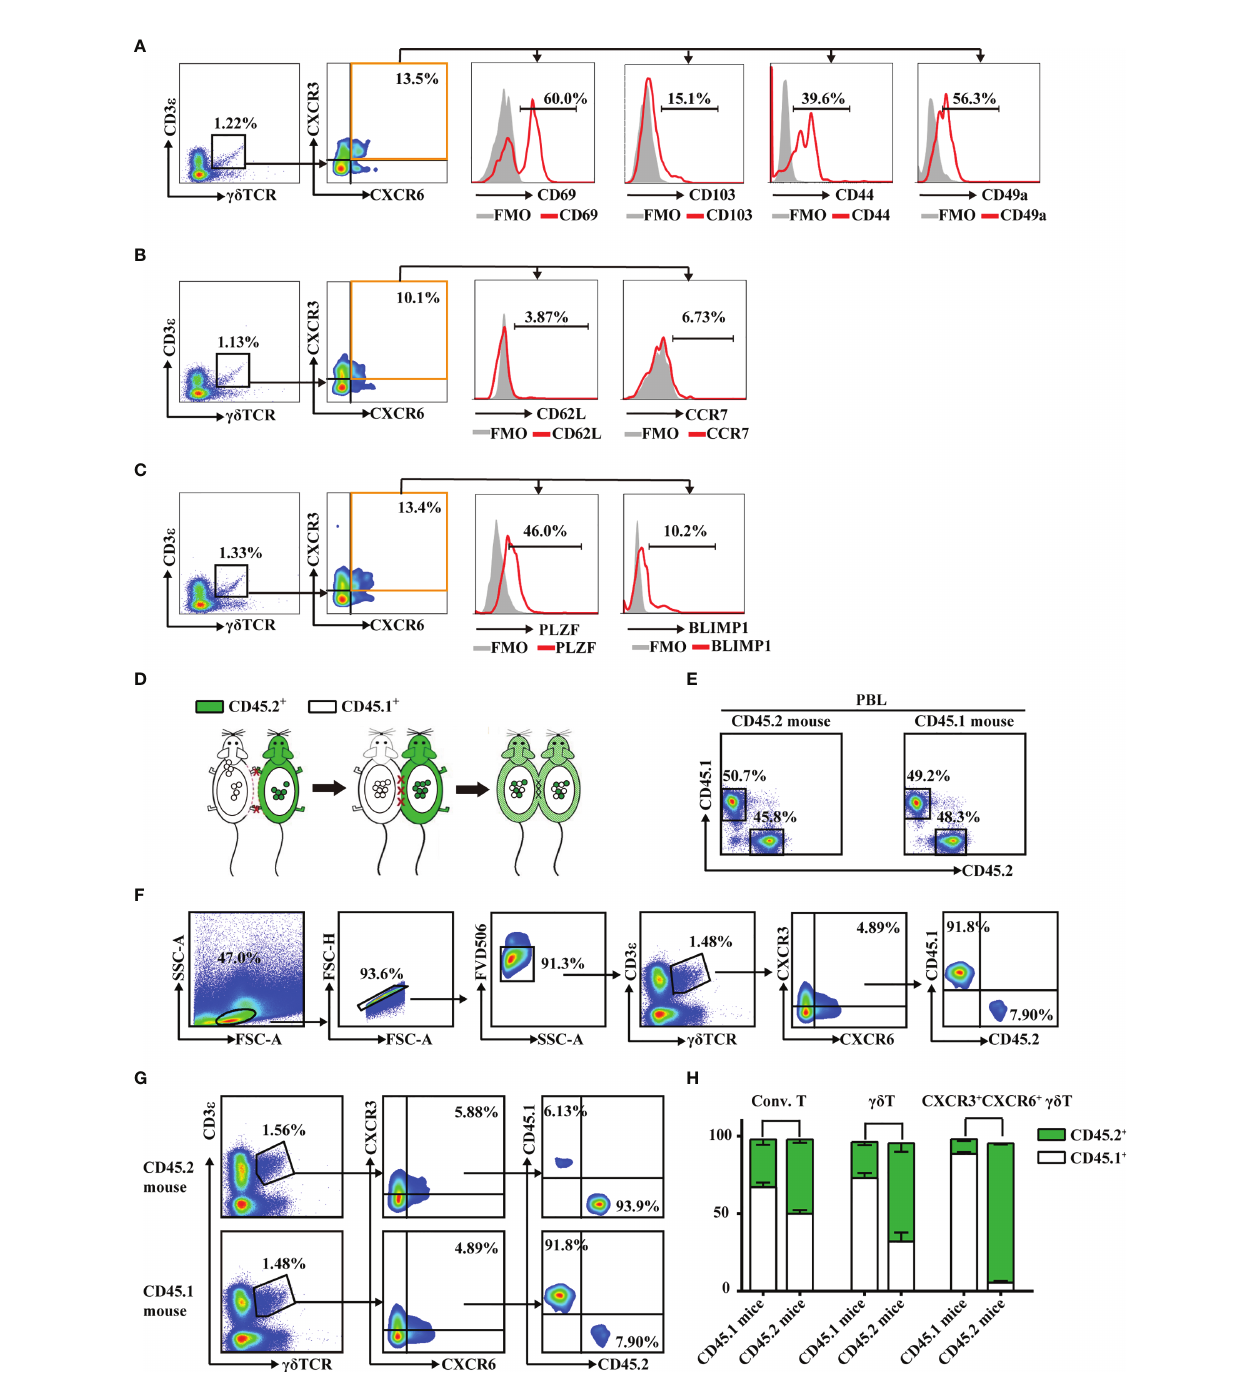
FIGURE 3 | CXCR3 + CXCR6 + gd T cells have tissue-resident characteristics and speci fi cally reside in liver. (A – C) FACS analysis of CD69, CD103, CD44, and CD49a (A) , CD62L and CCR7 (B) , and PLZF and Blimp1 (C) expression on hepatic CXCR3 + CXCR6 + gd T cells from C57BL/6J mouse livers. (D) Parabiotic joining of CD45.1 and congenic CD45.2 mice led to the development of a shared circulatory system 2 weeks after surgery. (E) The percentages of CD45.1 + and CD45.2 + cells in peripheral blood lymphocytes (PBLs) in parabiosis models. (F) Gating strategy of CD45.1 + or CD45.2 + expression on hepatic CXCR3 + CXCR6 + gd T cells. (G) The host origin (CD45.1 + or CD45.2 + ) of hepatic CXCR3 + CXCR6 + gd T cells was identi fi ed by FACS analysis in each mouse in the CD45.1/CD45.2 parabiotic mouse pairs at 14 days postsurgery. (H) The percentage of CD45.1 + or CD45.2 + conventional T cells (CD3 + TCR gd - NK1.1 − ), gd T cells (CD3 + TCR gd + ), and CXCR3 + CXCR6 + gd T cells from the liver of CD45.1/CD45.2 parabiotic B6